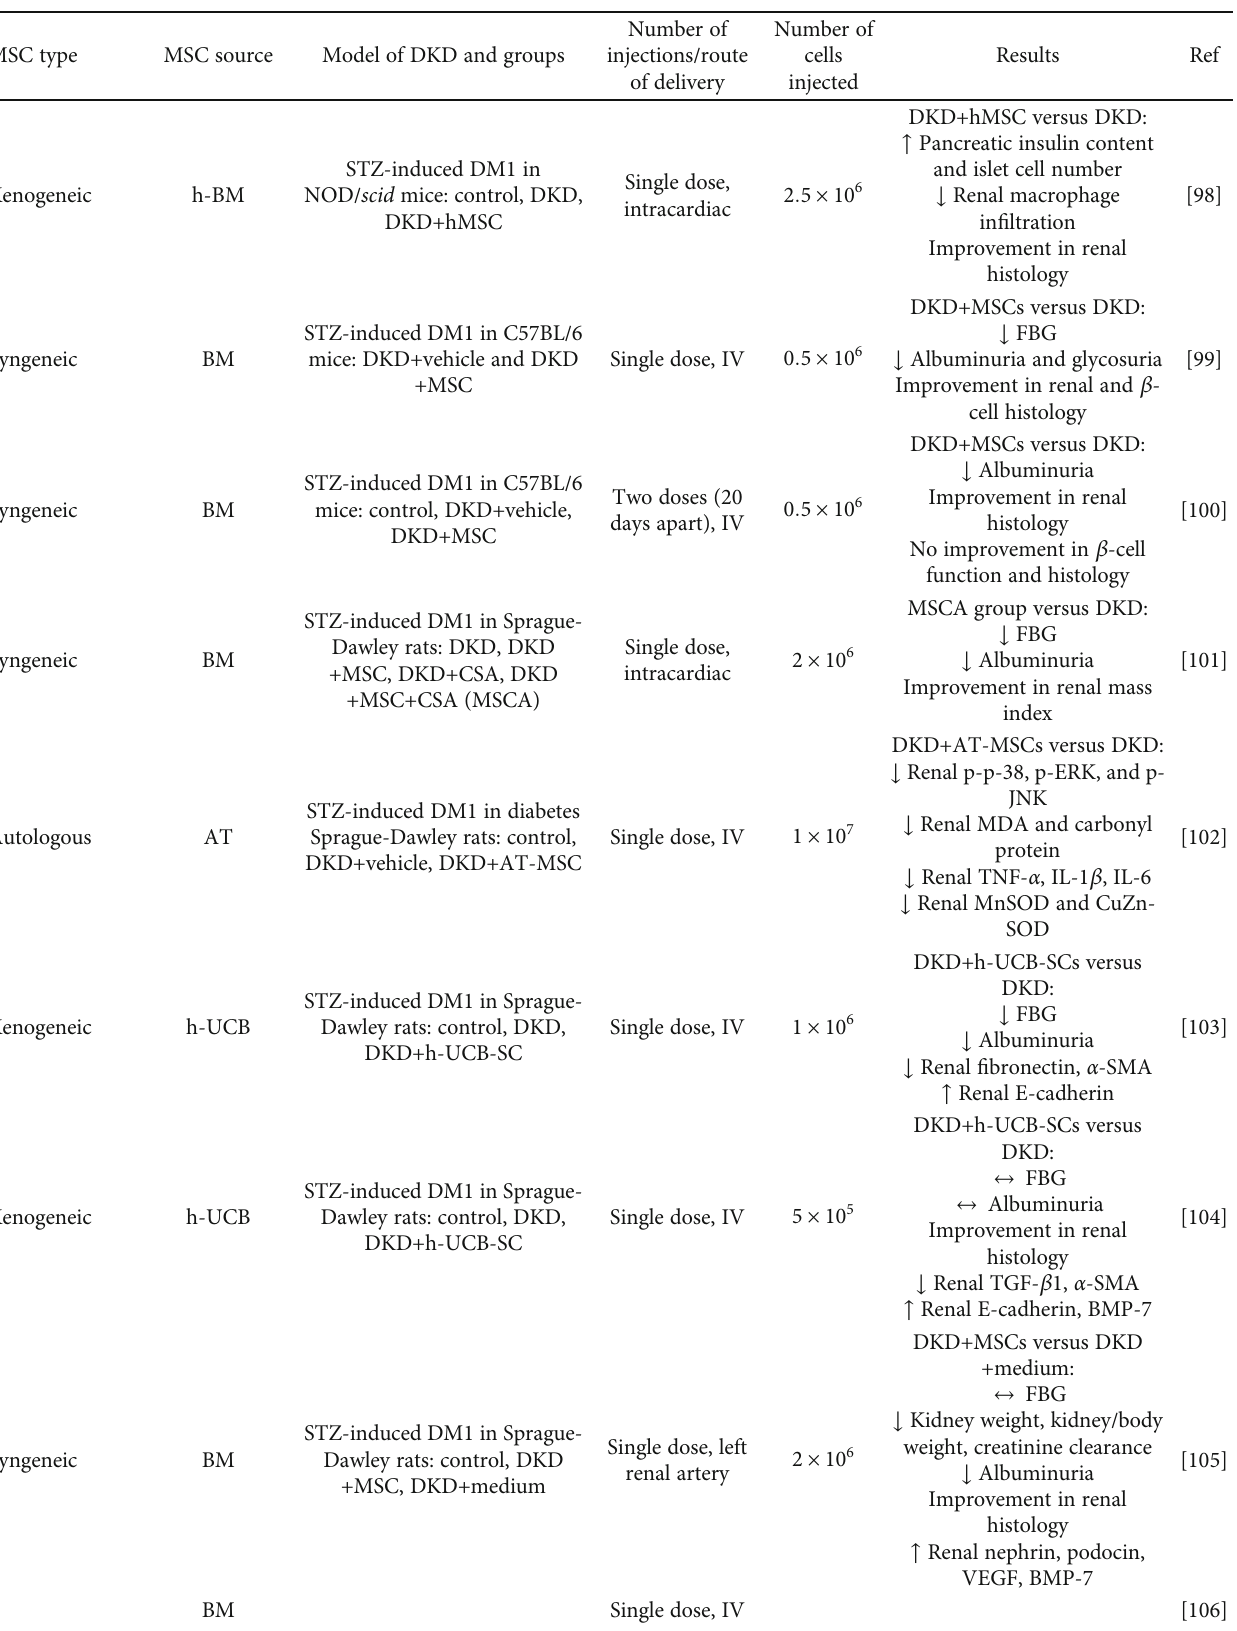
Table 1: Preclinical studies in small and large animals to verify the therapeutic potential of MSCs in